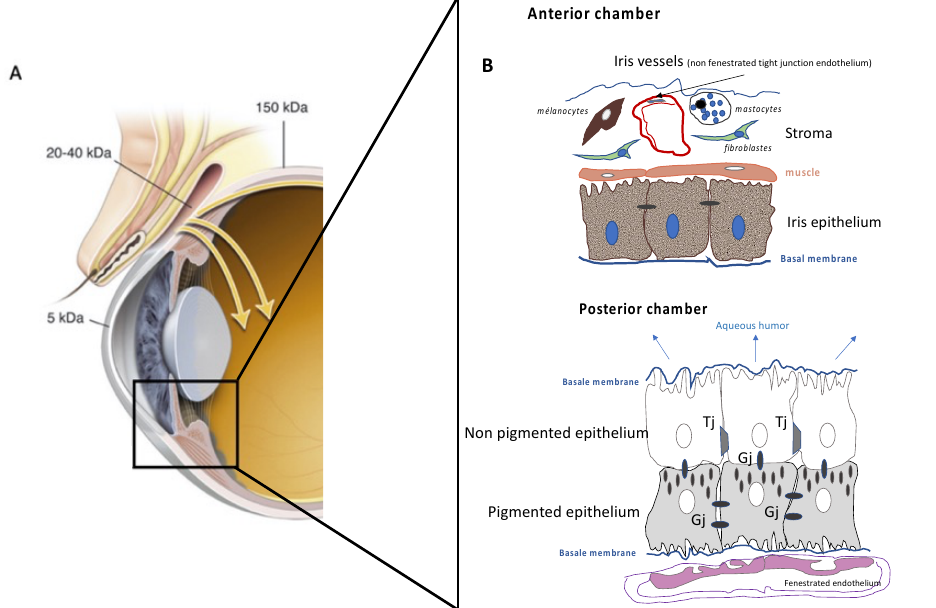
Figure 2. Hemato-aqueous barrier. ( A ) Macroscopic representation of the anterior part of the ocular globe. The molecular weights indicate the size limit for molecular passage through the outermost tissues (conjunctiva, cornea, anterior sclera). Inset: location of the two major components of the blood–aqueous barriers are identified as iris vessels (1) and nonpigmented ciliary body epithelia (2). ( B ) Schematic representation of the components of the blood–aqueous barrier in the iris where all cell components are represented with the iris vessels and its tight-junction endothelial cells (1) (upper image), as well as the ciliary body, with all its cellular components and its tight-junction nonpigmented epithelium (2) (lower image). TJ: tight junctions, GJ: gap junctions.